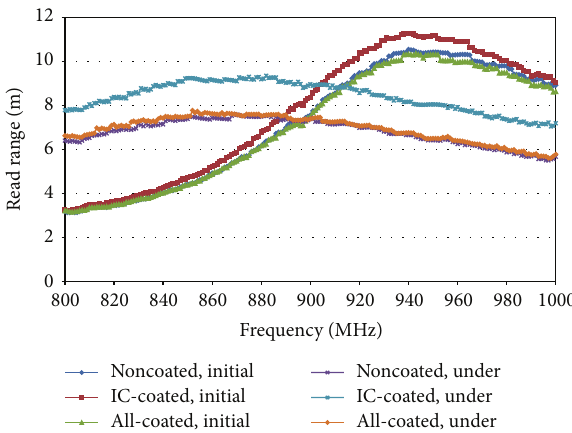
Figure 7: Measurement results under 4 cm thick wooden layer.